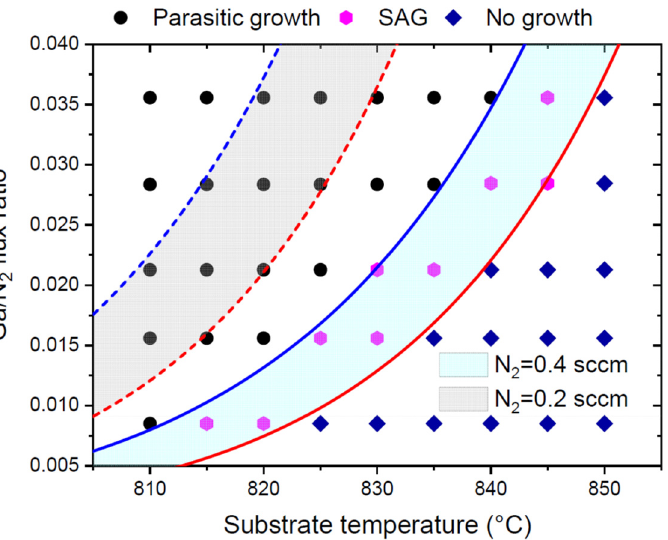
Figure 3. SAG windows for vertical GaN NWs grown by PA-MBE on patterned SiO x /Si(111) in terms of temperature-dependent Ga/N 2 flux ratios at two different N 2 flows shown in the legend. The curves are obtained from Equation (23) without surface diffusion. Symbols correspond to parasitic growth, true SAG, and no-growth conditions observed experimentally for N 2 flux corresponding to 0.4 sccm [20].